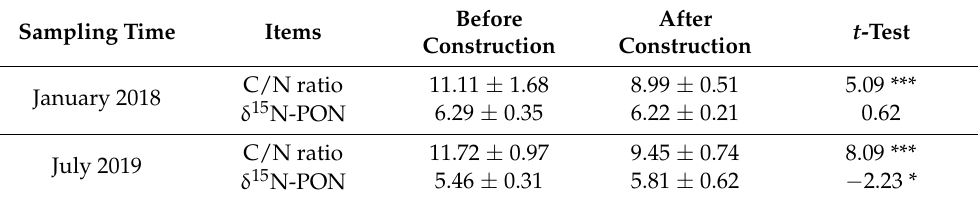
Table 5. Statistics of C/N ratio and δ 15 N-PON at different sampling periods. Sampling